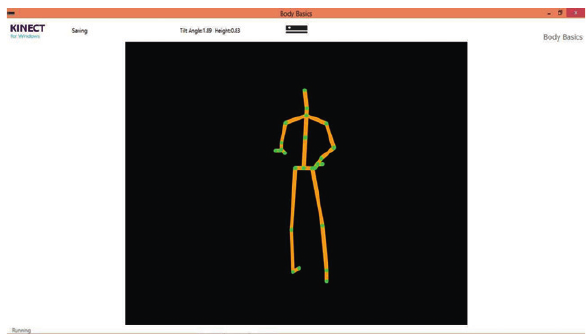
Fig. 1: The SDK for Kinect system and virtual skeleton formed by Kinect and the tilt adjustment.